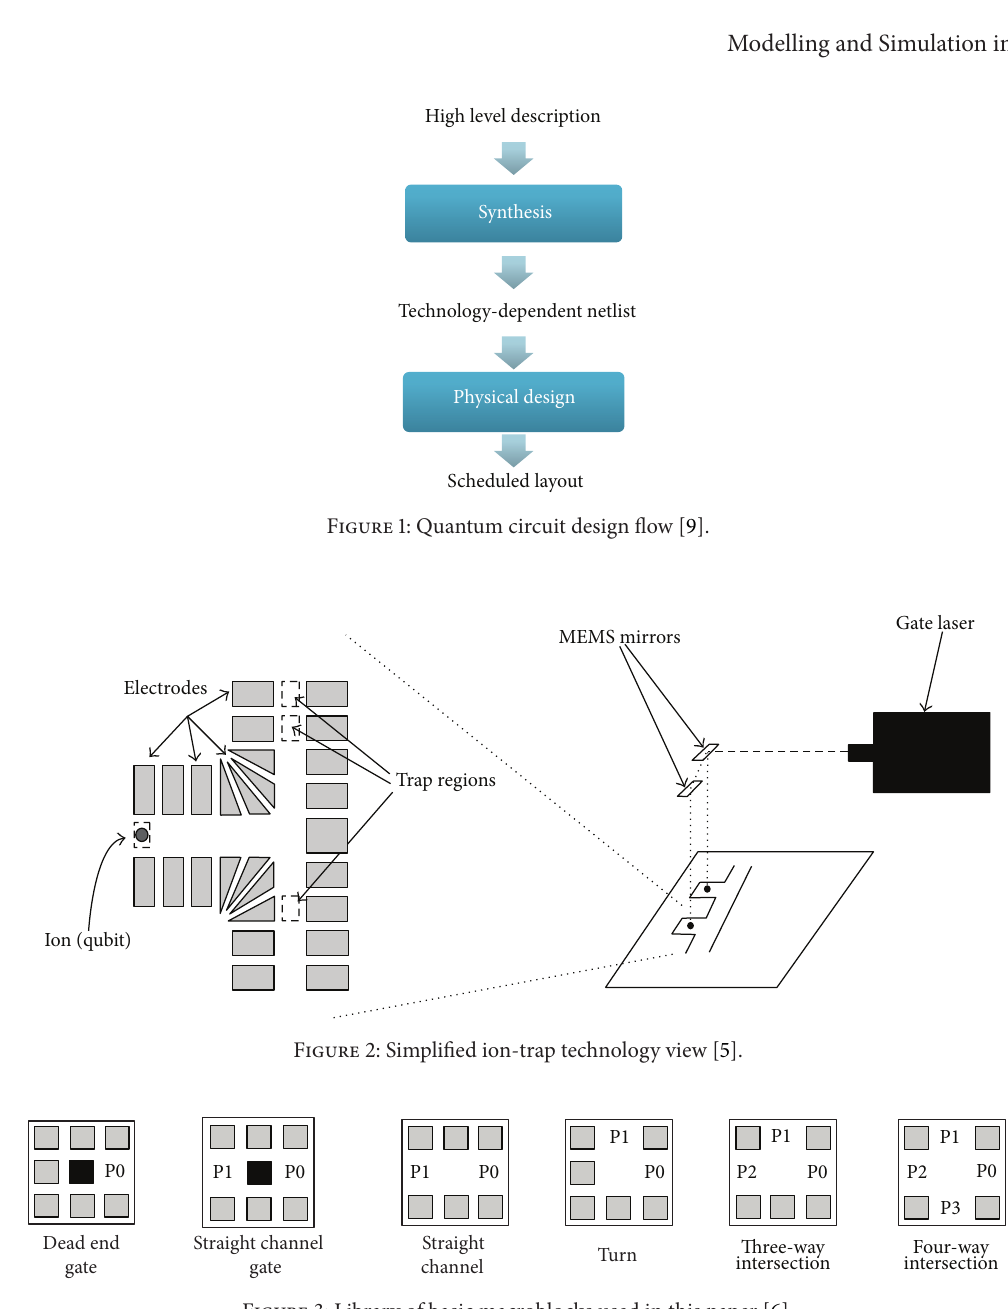
Figure 3: Library of basic macroblocks used in this paper